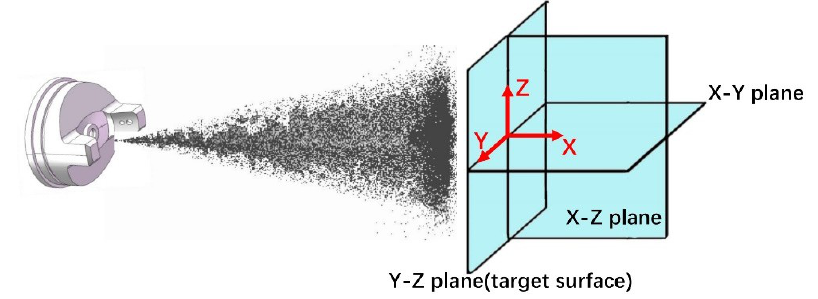
Figure 3. External flow field of the nozzle. Coatings 2019 , 9 , x FOR PEER REVIEW